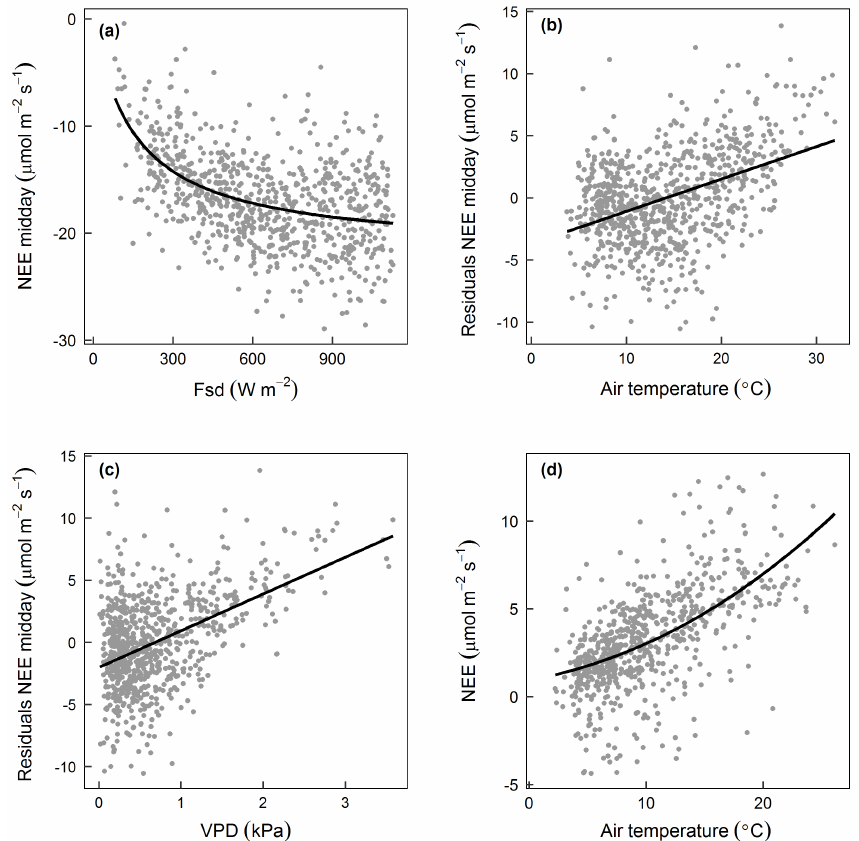
Figure 5. (a–c) Relationship between daily means of midday NEE and (a) incoming solar radiation ( F sd ) as a rectangular hyperbolic light-response curve (LRC), linear fits between residuals of LRC and (b) air temperature ( T a ) or (c) vapour pressure deficit (VPD). (d) Re- lationship between daily means of u ∗ -filtered night-time NEE and air temperature ( T a ) as a temperature-response function after Lloyd and Taylor (1994); R 2 values are given in Tables 3 and 5. Table 3. Parameters, standard errors and/or the coefficient of determination ( R 2 ) of (a) the rectangular hyperbolic light-response curve (LRC) between daily means of midday NEE and incoming radiation ( F sd ), (b) linear fits between residuals of LRC and air temperature ( T a ) or vapour pressure deficit (VPD), and (c) linear fits between second residuals (b) with T a and soil water content (SWC) for subsets of data. α : initial slope of LRC and canopy light-utilization efficiency (µmolCO 2 J − 1 ); β : maximum NEE (i.e. uptake rate of the canopy) at